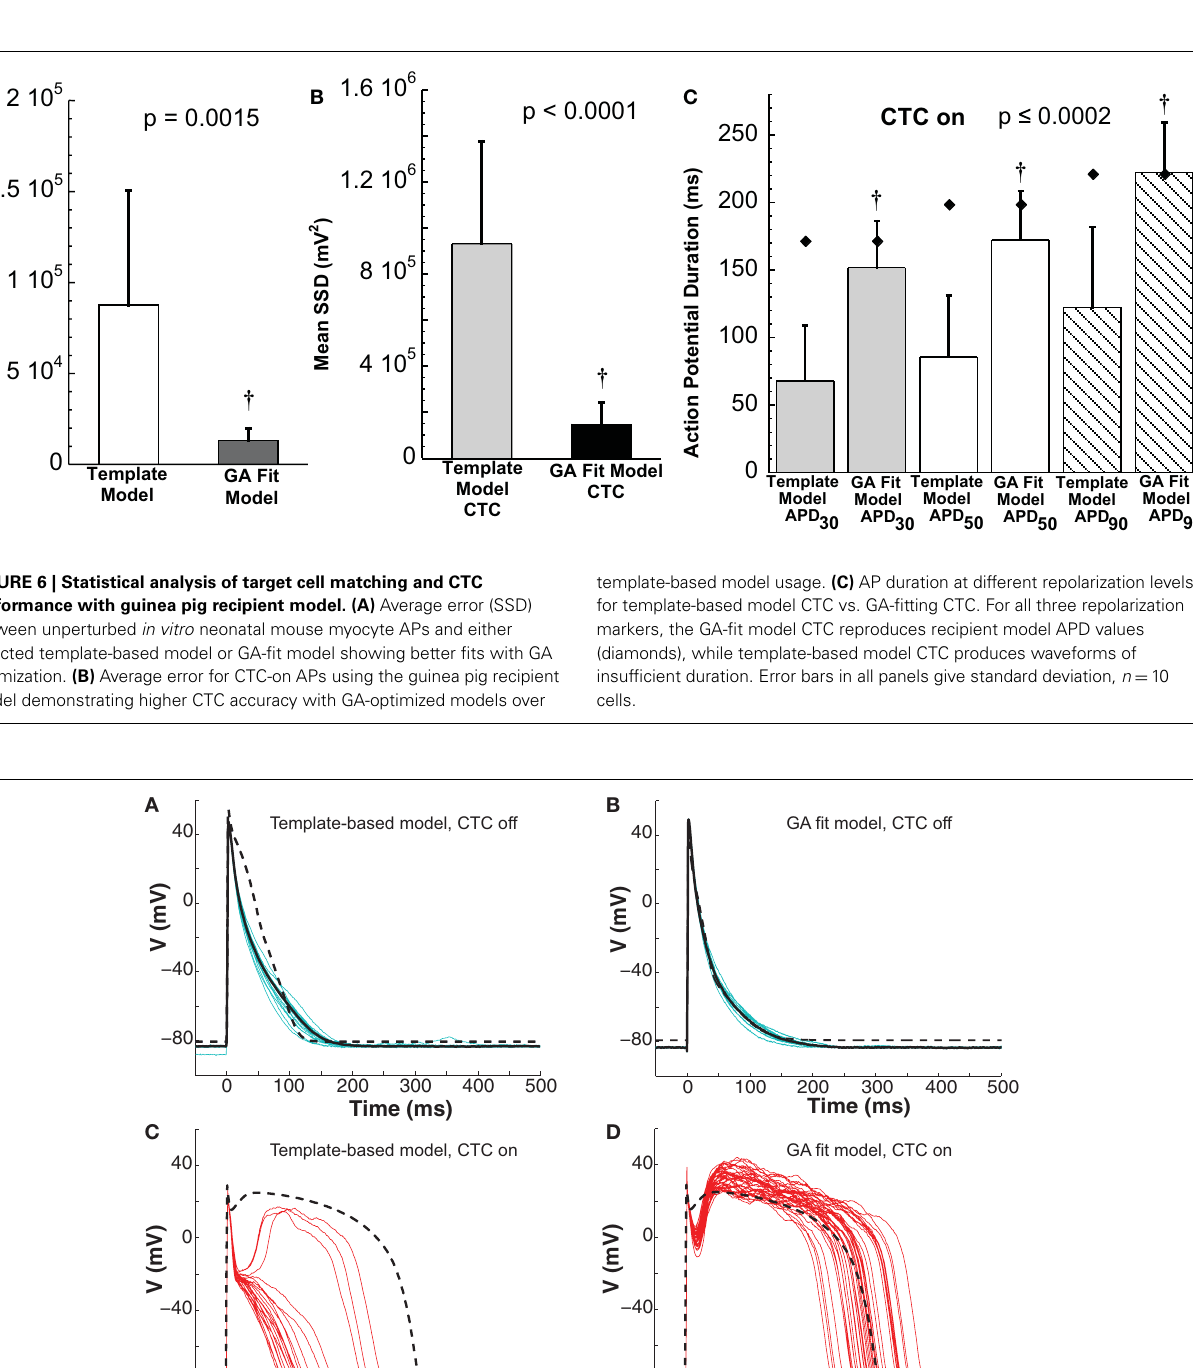
FIGURE 7 | Neonatal mouseAPs anthropomorphized to humanAP. (A) Ten consecutive neonatal mouse myocyte APs (cyan traces) recorded in vitro , their average (solid black line), and the APD 80 -based nominal model (dashed line). (B) Ten APs from the same murine myocyte (cyan traces), their average (solid black line), and the GA-optimized model (dashed line).